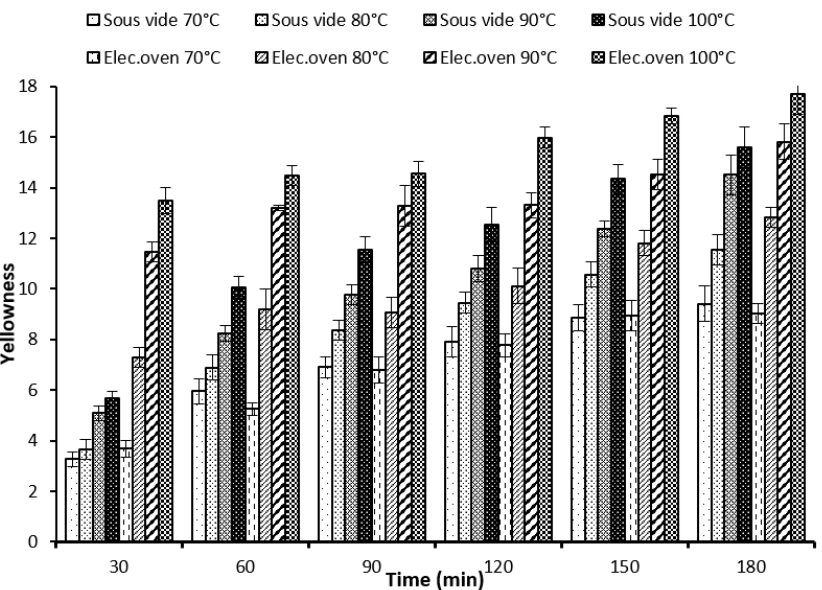
Figure 7. The effect of the cooking method (sous vide vs electrical oven) on the camel meat color components (yellowness b*) at different combinations of temperature and time. components (yellowness b*) at different combinations of temperature and